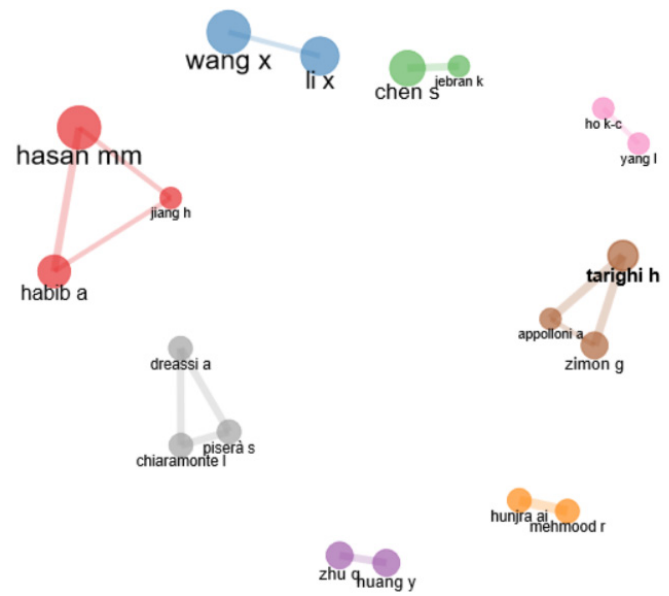
Figure 3. Author collaboration network. Source: Scopus/Biblioshiny.